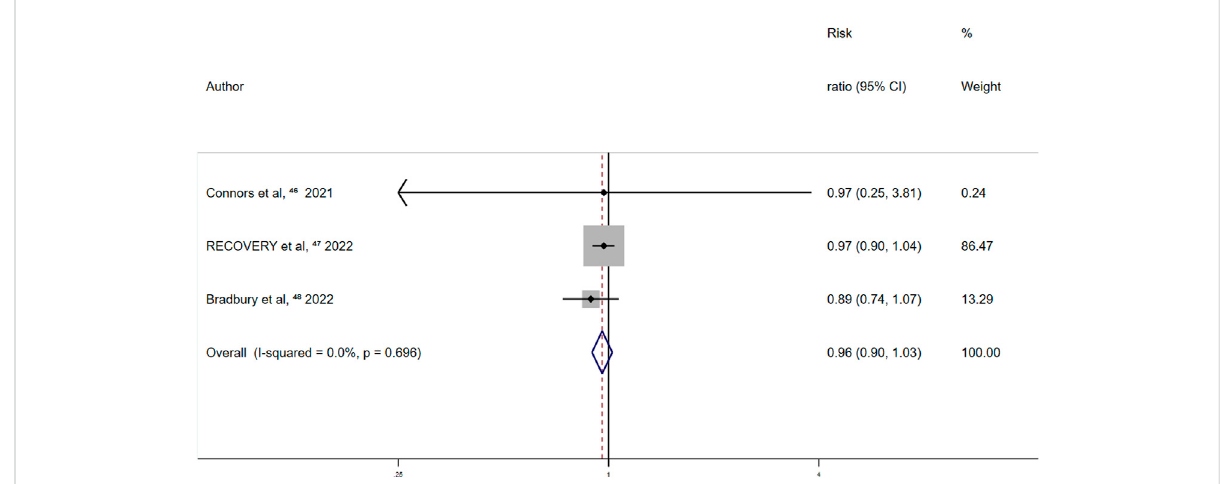
FIGURE 2 Summary hazard ratio of all-cause mortality for aspirin use in randomized controlled trials.